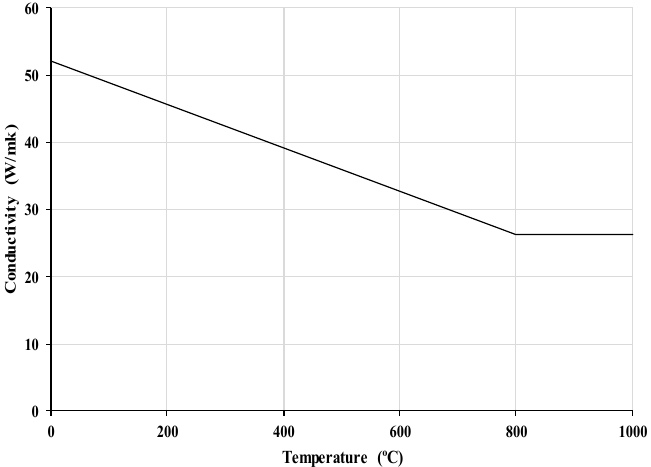
Figure 7. Thermal conductivity of carbon steel as a function of temperature.